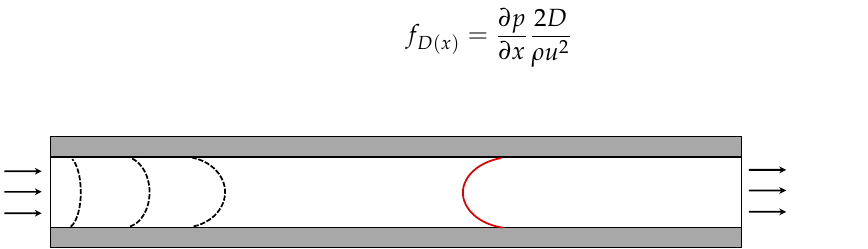
Figure 4. Velocity (dashed) and temperature (solid) profiles inside of a channel. The arrows indicate the flow direction.